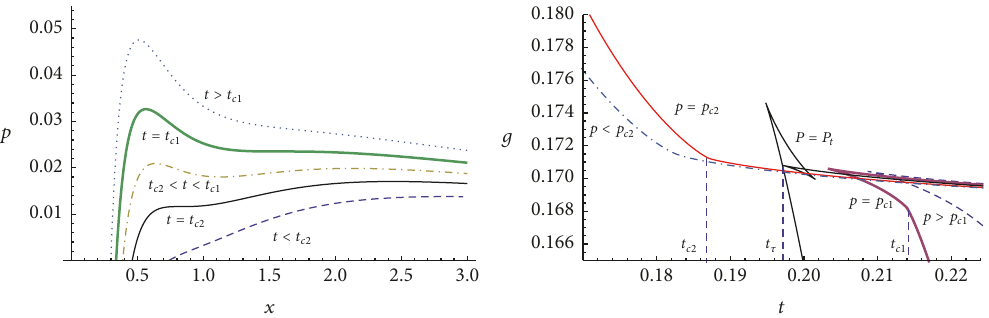
Figure 4: Born-Infeld AdS black holes for 𝑑 = 4 and 𝑤 2 = −0.14 . There are two critical points at positive pressure.